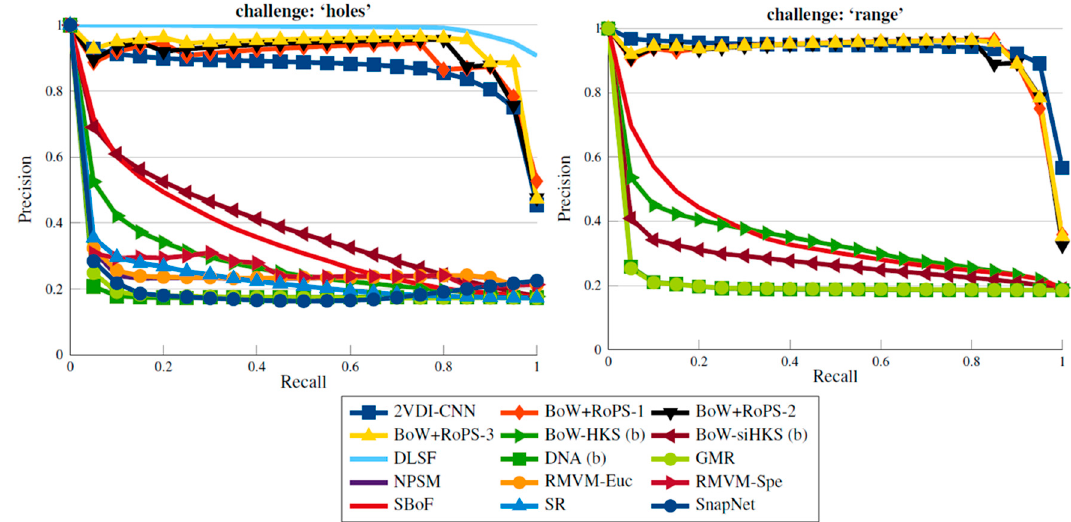
Figure 8. Precision-recall curves for all methods in the two challenges. Left graph is for irregular holes, right graph is for range data. 2VDI-CNN: 2D-view depth image- and CNN-based method. Table 3. Retrieval performance for the Irregular holes challenge, sorted decreasingly by the neural network (NN) score. Best results are reported in bold. DCG: discounted cumulative gain.